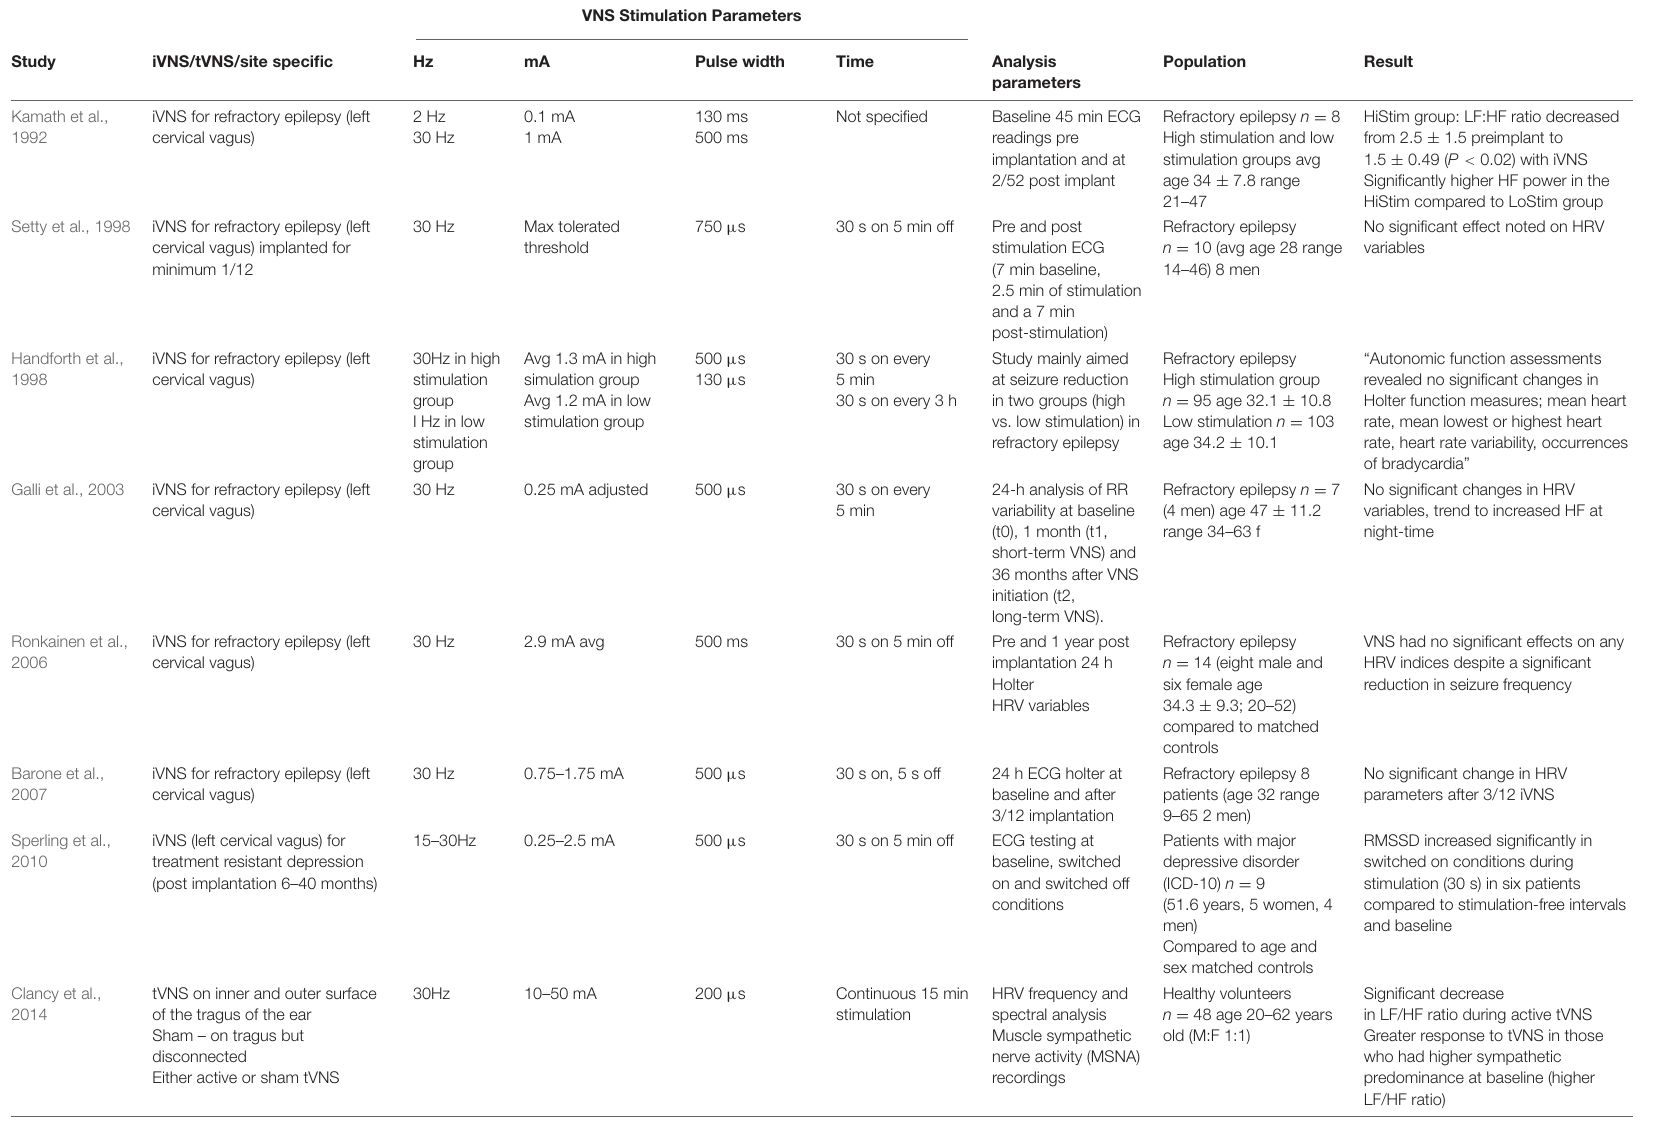
TABLE 4 | VNS and neurocardiovascular